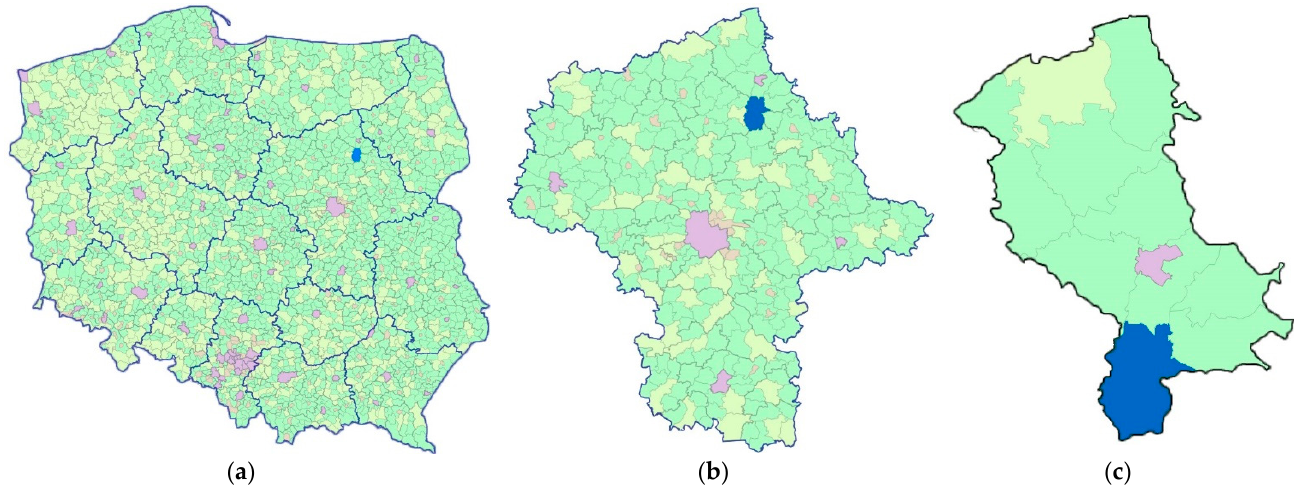
Figure 1. Position of the commune of Goworowo (blue): ( a ) in Poland; ( b ) in the Mazowieckie Voivodship; ( c ) in the Ostro łę cki District.